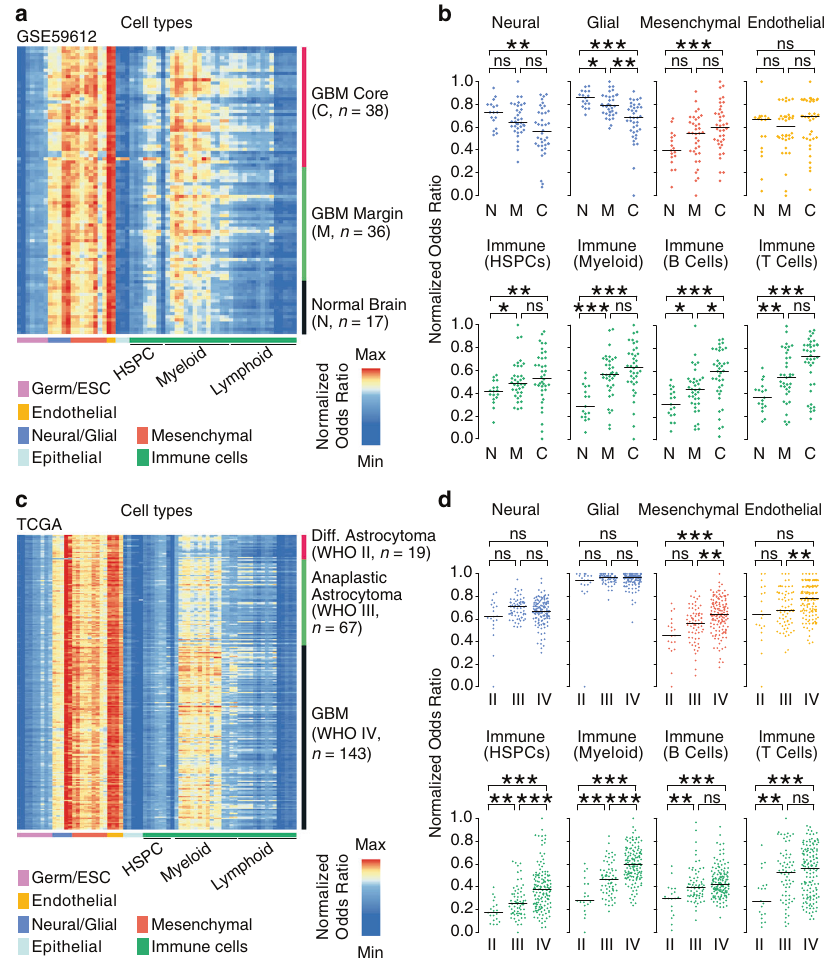
Fig. 2 HSPCs are enriched in glioblastoma and associate with tumor grade. a Heatmap represents Syllogist signals for each cell type (columns) and patient samples (rows) for data derived from Gill et al. 26 , including core, margin and normal brain tissue samples ( n = 91 samples). GBM Glioblastoma, HSPC Hematopoietic stem and progenitor cell, ESC Embryonic stem cell, Mø Macrophages. b Association of brain sample locations with Syllogist normalized odds ratios of eight selected cellular compartments. Dot plots represent the samples from normal brains (N, n = 17 samples), glioblastoma margins (M, n = 36), and cores (C, n = 38). c Heatmap represents Syllogist signals for each cell type (columns) and patient samples for the LGG-glioblastoma cohorts 29,30 ( n = 229 samples). d Association of tumor grade with normalized odds ratios of eight main cellular compartments. Dot plots represent the samples from diffuse astrocytoma (WHO grade II, n = 19 samples), anaplastic astrocytoma (WHO grade III, n = 67) and glioblastoma (WHO grade IV, n = 143). p values were determined by 2-tailed, unpaired Student ’ s t -test with correction by the Benjamini – Hochberg procedure. *, p <0.05; **, p <0.01; ***, p <0.001; ns not signi fi cant. For ( b ) and ( d ), the exact p values are reported in Supplementary Data 2 and 3, respectively. Source data of ( b ) and ( d ) are provided as a Source Data fi